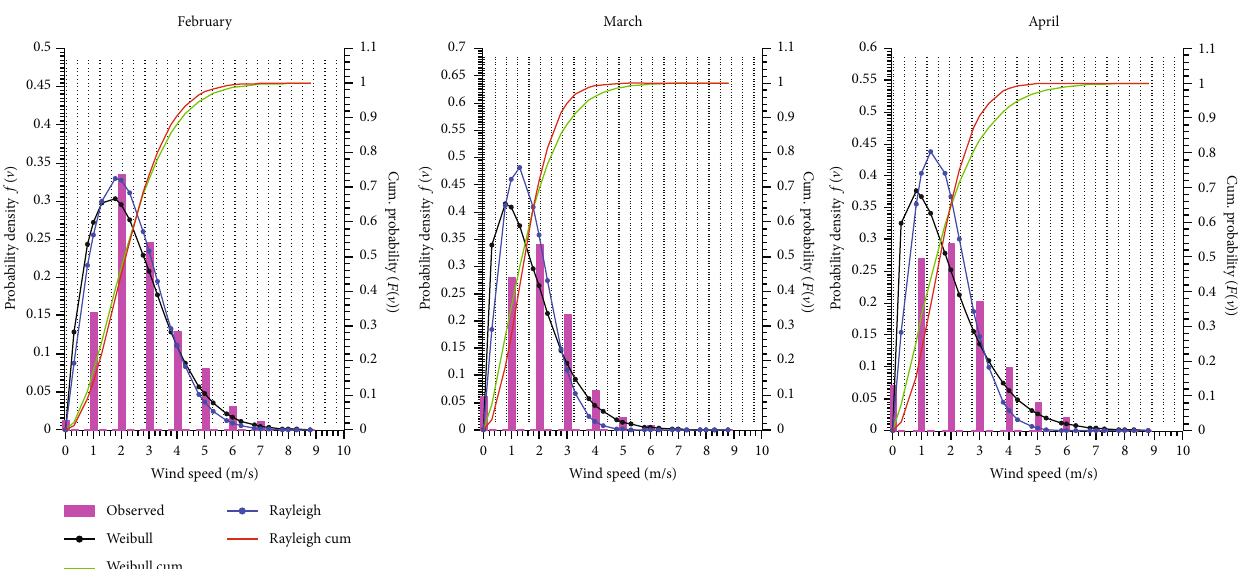
Figure 7: Observed histogram, Weibull, and Rayleigh probability and cumulative curves for February, March, and April (2018) (Tables 27 – 29 in Supplementary